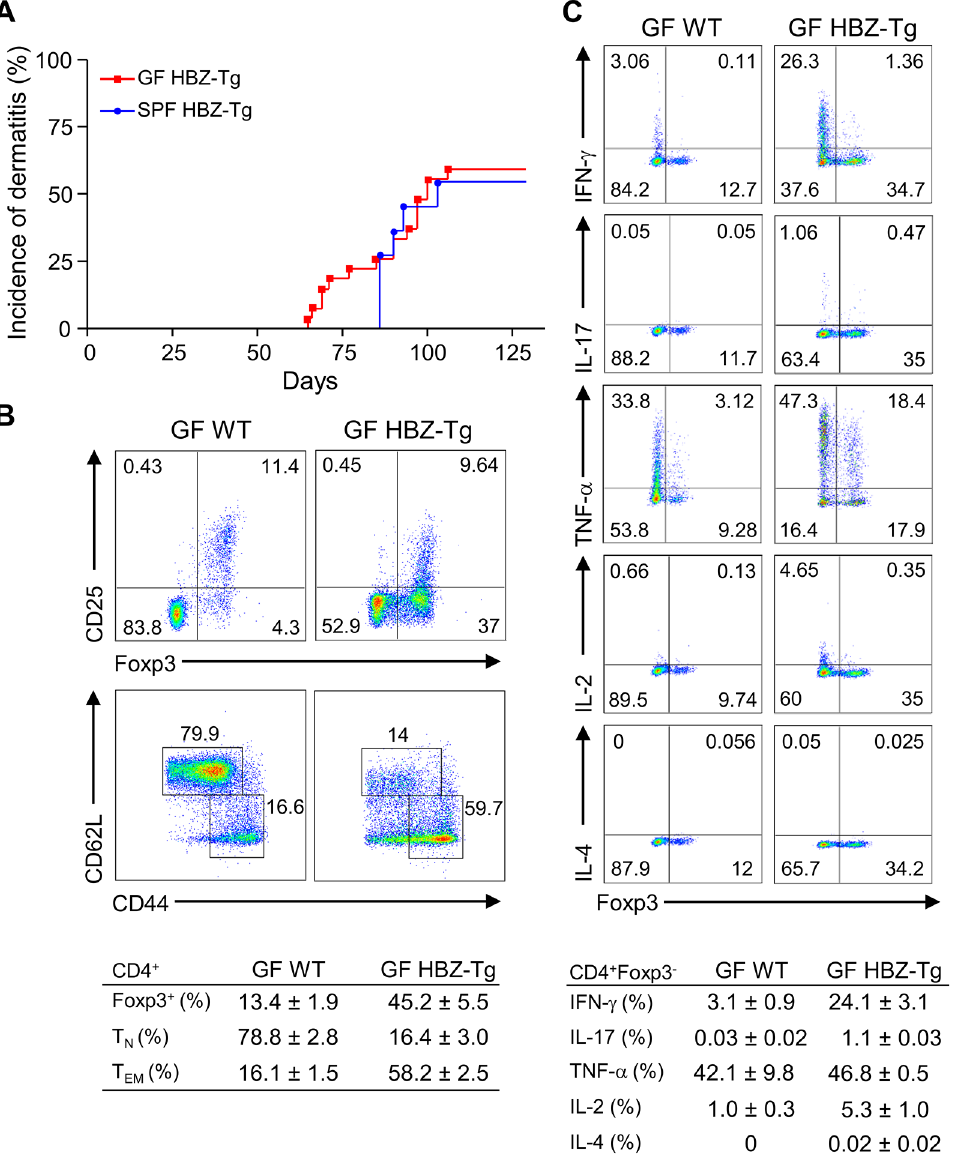
Fig 3. Inflammatory phenotypes of germ-free HBZ-Tg mice. (A) GF HBZ-Tg mice developed dermatitis similarly to SPF HBZ-Tg mice. (B) Splenocytes were harvested from 18-week-old GF HBZ-Tg or GF WT littermates. The percentages of Tregs and effector/memory CD4 + T cells were evaluated. Representative results of the dot plots and a summarized table are shown. (C) Cytokine production in CD4 + T cells was evaluated. Splenocytes were stimulated with PMA/ionomycin in the presence of protein transport inhibitor for 4 hours, stained with specific antibodies, and analyzed by flow cytometry. Representative results of the dot plots and a summarized table are